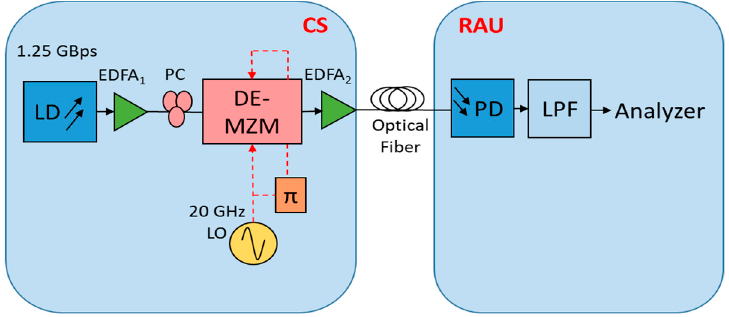
Figure 2. DSB-OCS simulation setup.